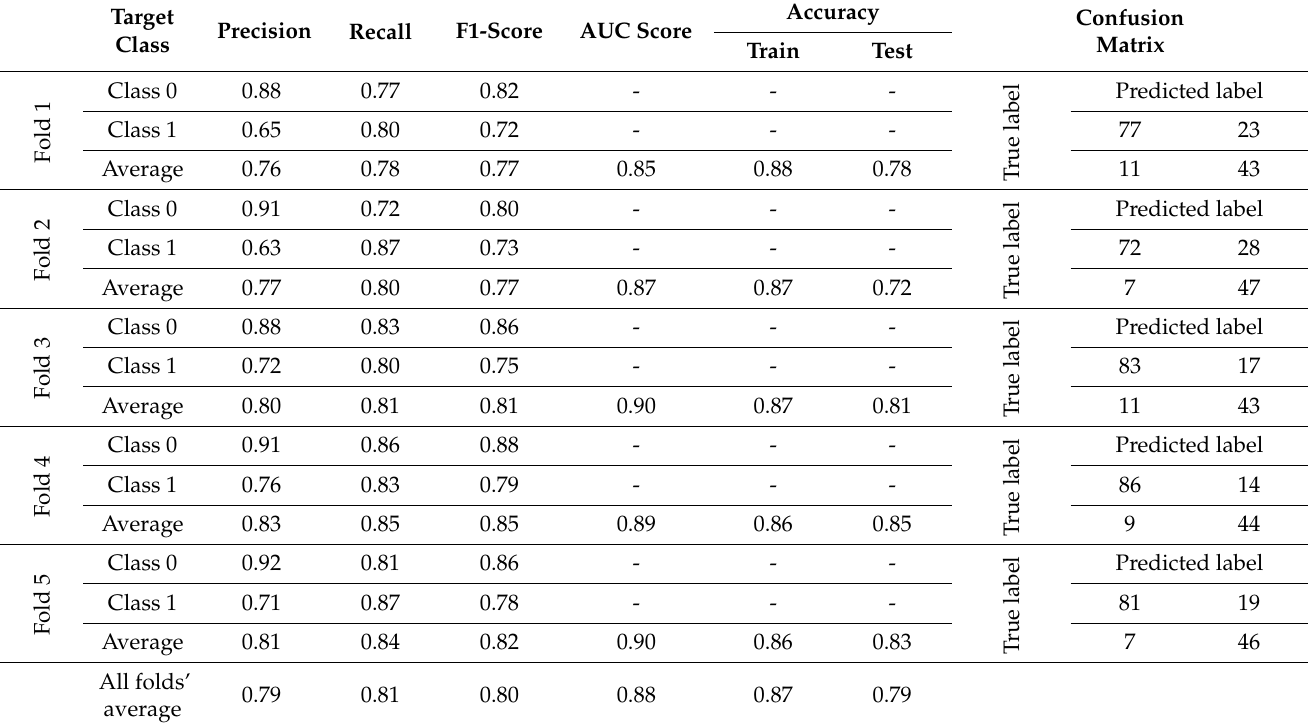
Table A2. SVM model’s performance for the five-fold cross-validation.